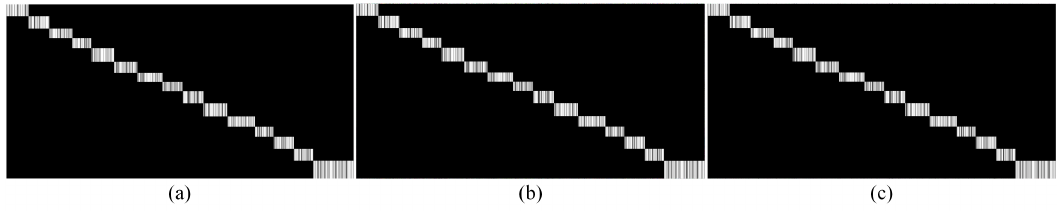
Figure 6. An visualized example of the pre-mapping construction for the preference matrix A ( N e − ug = 15, I = 15). ( a ) is the original preference matrix; ( b ) is the estimation result with 20% non-uniform samples (the similarity is 0.9942); ( c ) is the estimation result with 40% non-uniform samples (the similarity is